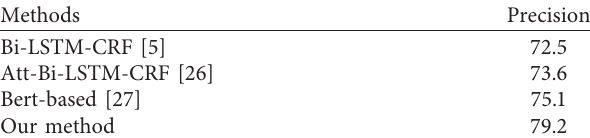
Table 3: English entity relationship extraction results.